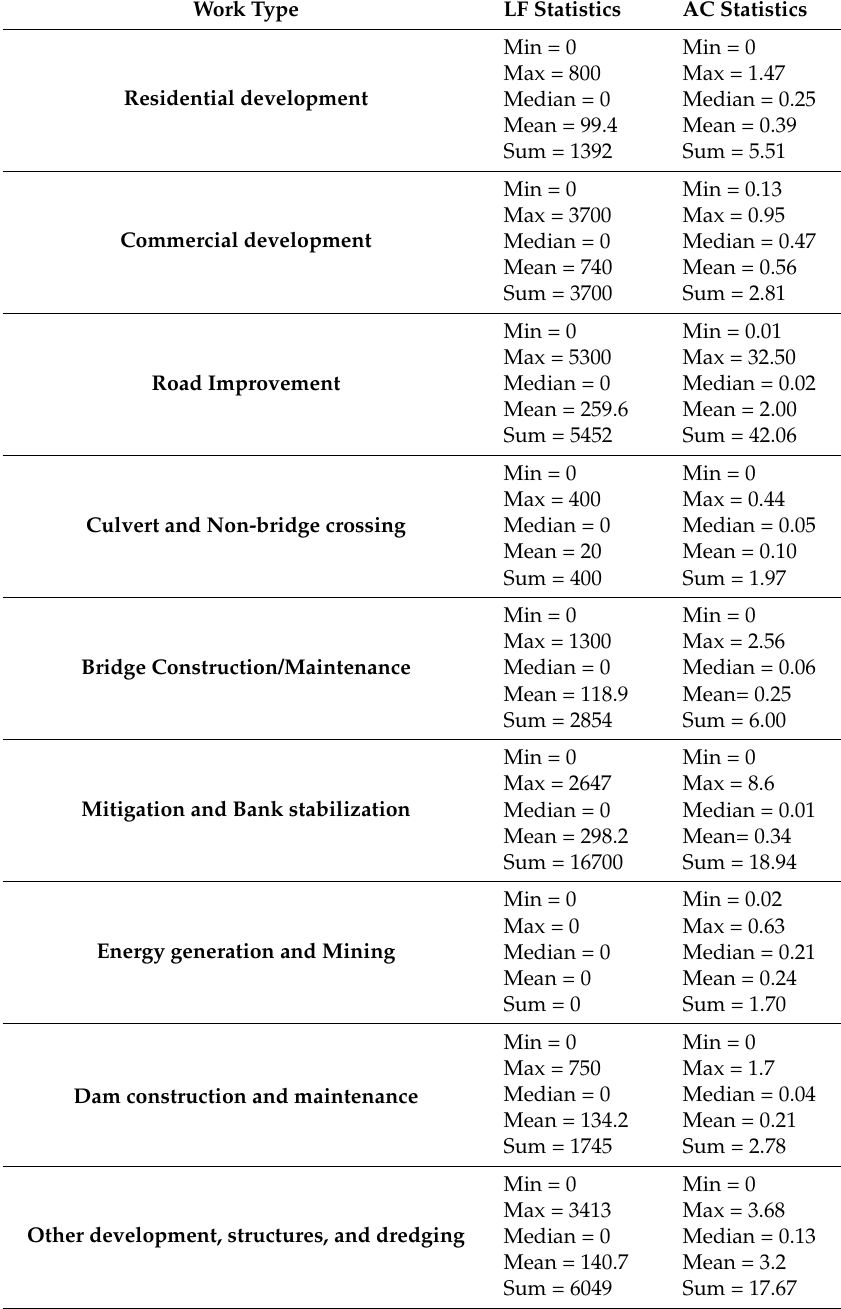
Table 5. Permanent riverine impacts in Colorado (2012–2017) requiring compensatory mitigation by development type. Values of linear feet (LF) and acres (AC) are the impacted length/area requiring mitigation, not the mitigation credits that were